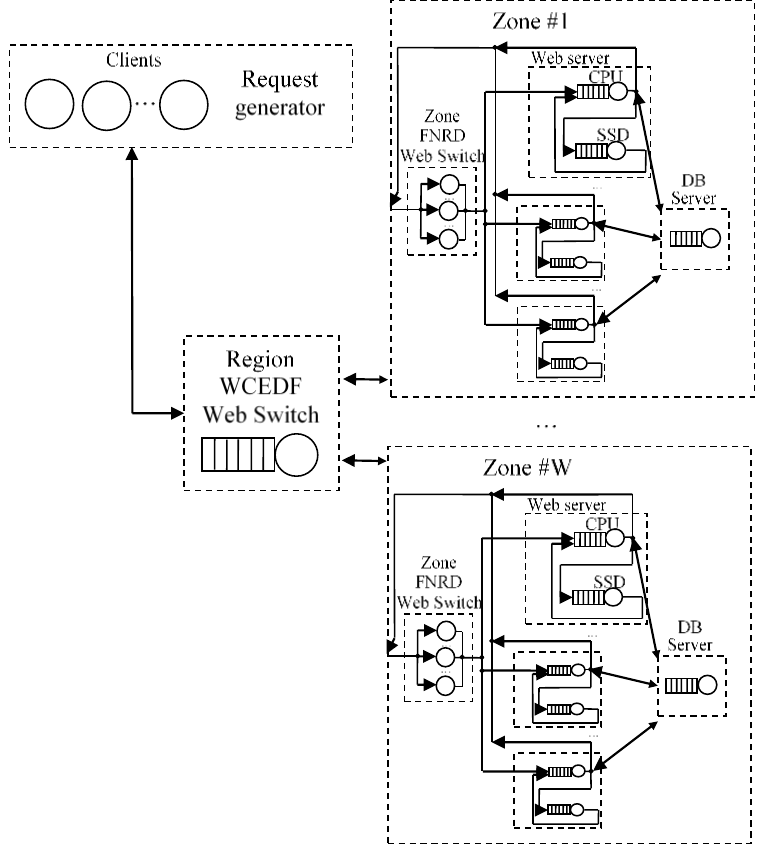
Figure 4. Simulation model.